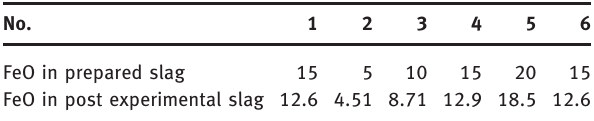
Table 2: FeO contents in the post experimental analysis, wt%. No.      